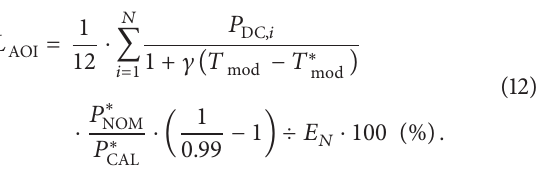
Table 3 gathers the values of PR , 𝐿 𝑇